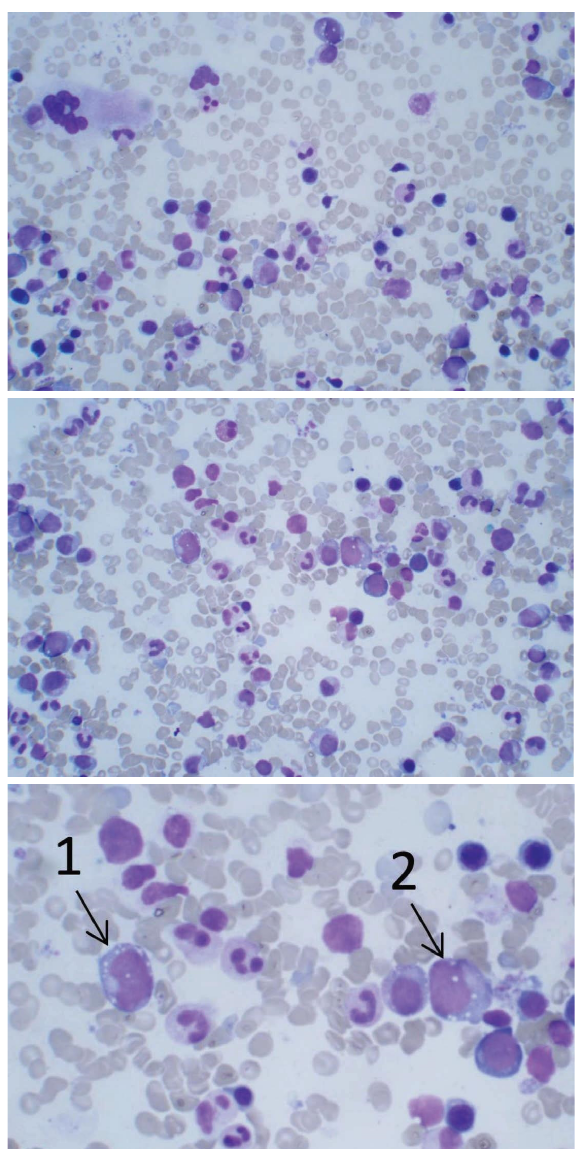
Figure 4: Picture from bone marrow smear demonstrating vacuolization in erythroid and myeloid cells, next to a normal